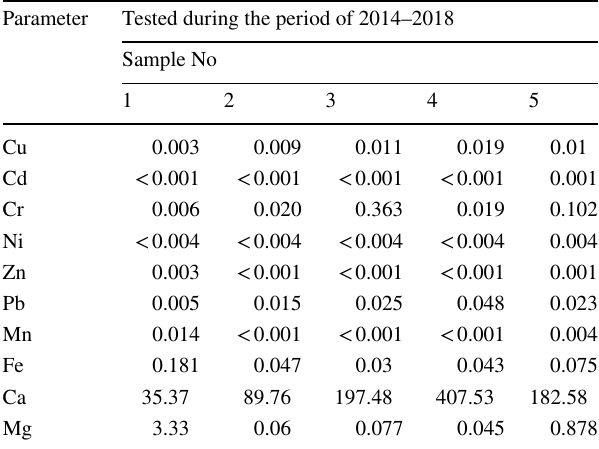
Table 3 Averaged content of heavy and alkali metals in leachate sam‑